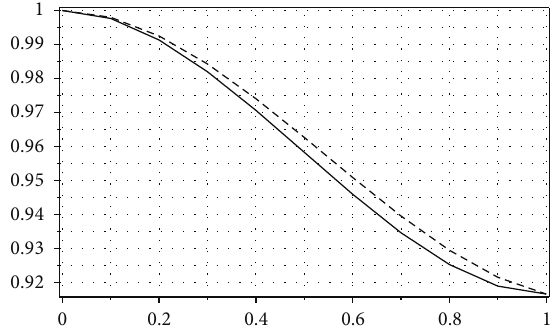
Figure 3: Comparison of the analytic and approximate solution of Example 3 by proposed algorithm. In this figure solid line shows exact solution and dashed lines show approximate solution by proposed algorithm.